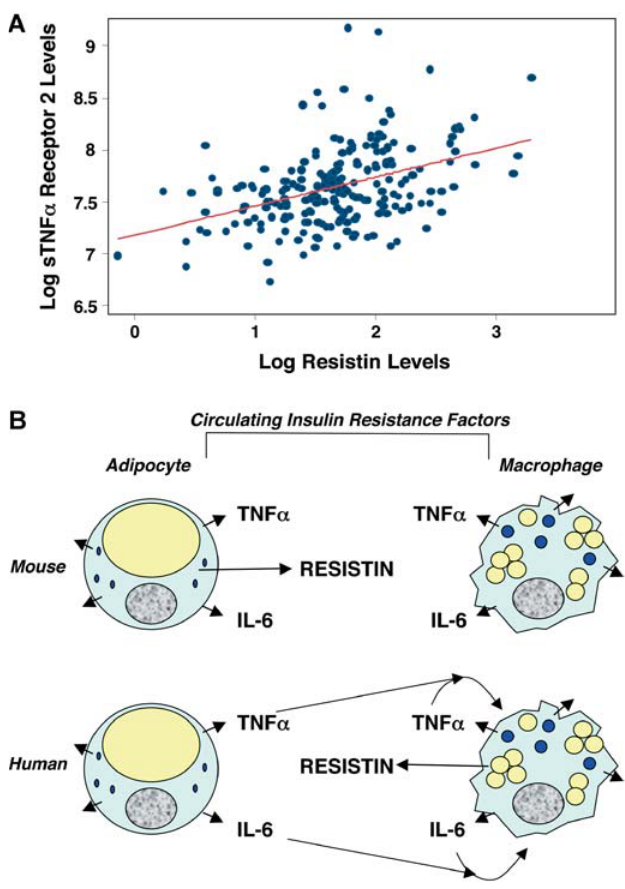
Figure 6. Plasma Resistin Levels Correlate with sTNFR2 Levels in Humans with Type 2 Diabetes (A) The correlation (Spearman coefficient rho = 0.38, p , 0.001) of plasma resistin and sTNFR2 levels in 215 humans with type 2 diabetes is presented. The line represents the linear regression fit between log- transformed plasma levels of resistin and sTNFR2. (B) Model to explain hyperresistinemia in mice and humans with obesity despite the species differences in the source of plasma resistin. Circulating inflammatory cytokines TNF a and IL-6 are depicted because of their role in resistin induction in human macrophages and their implied role in insulin resistance. Other cytokines and inflammatory markers may also contribute to insulin resistance and/or resistin induction. DOI: